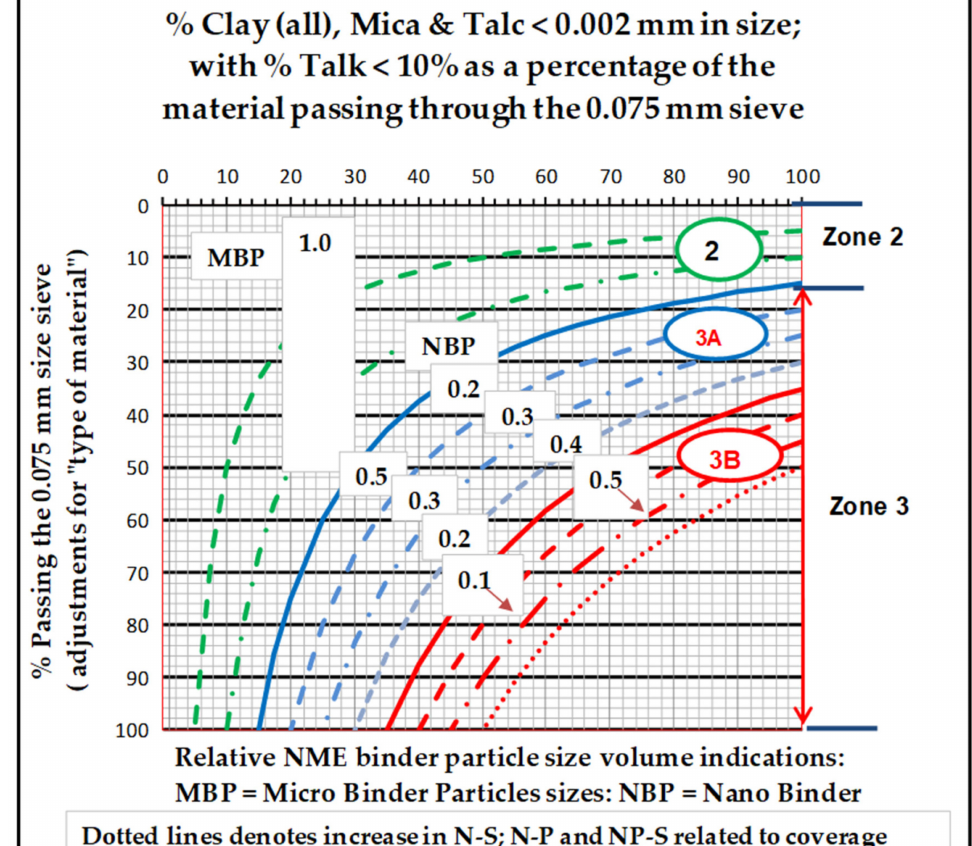
Figure 21. Selection of an applicable stabilising agent to be used in conjunction with the selected modifying agent (NME) to effectively stabilise the material and meet the required engineering properties in terms of stresses, strains and